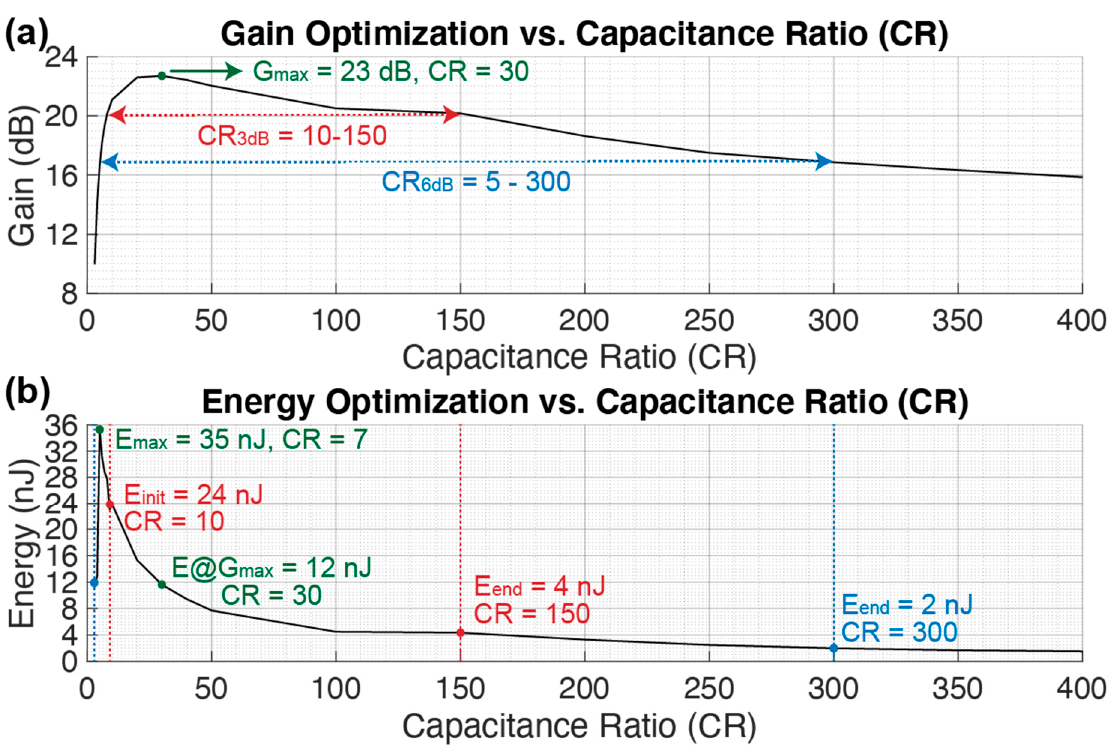
Figure 8. Gain ( a ) and energy ( b ) optimization over a sweep on the capacitance ratio CR. The remaining values are maintained constant as in Table